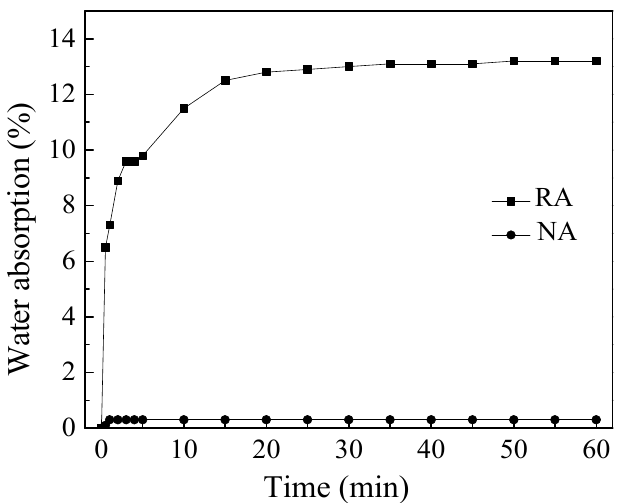
Figure 1. Time varying curve of water absorption for coarse aggregate.